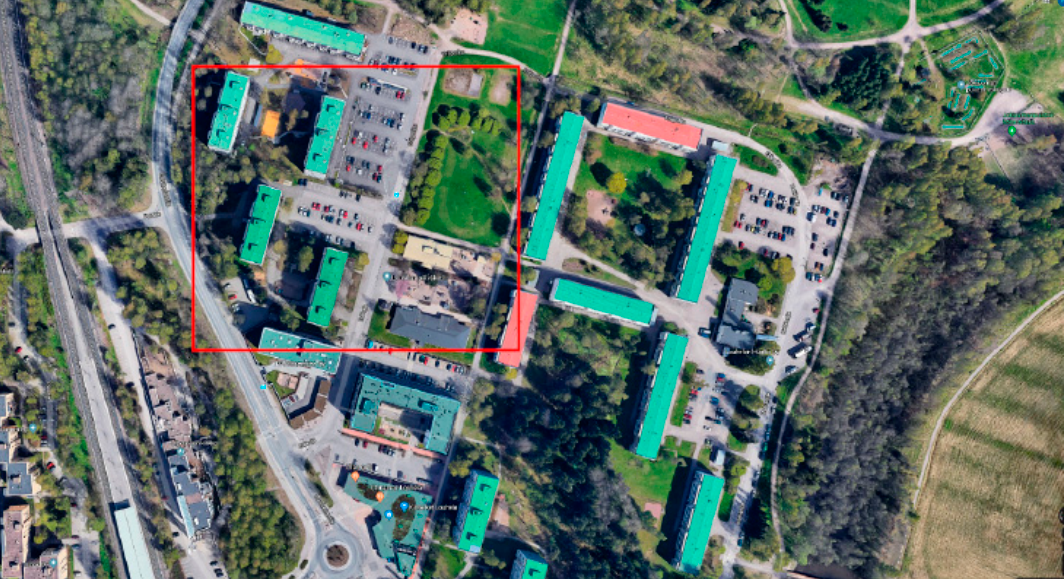
Figure 1. Louhela area showing the four buildings built during the 1970s in Vantaa, Finland [76].